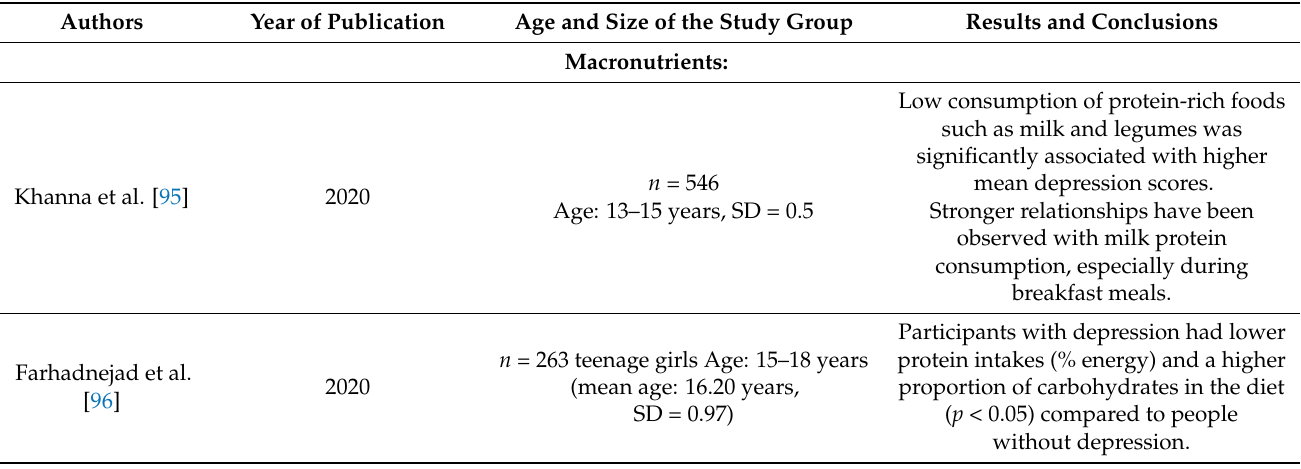
Table 2. Macronutrients in the diet of children and adolescents suffering from adolescent depression.